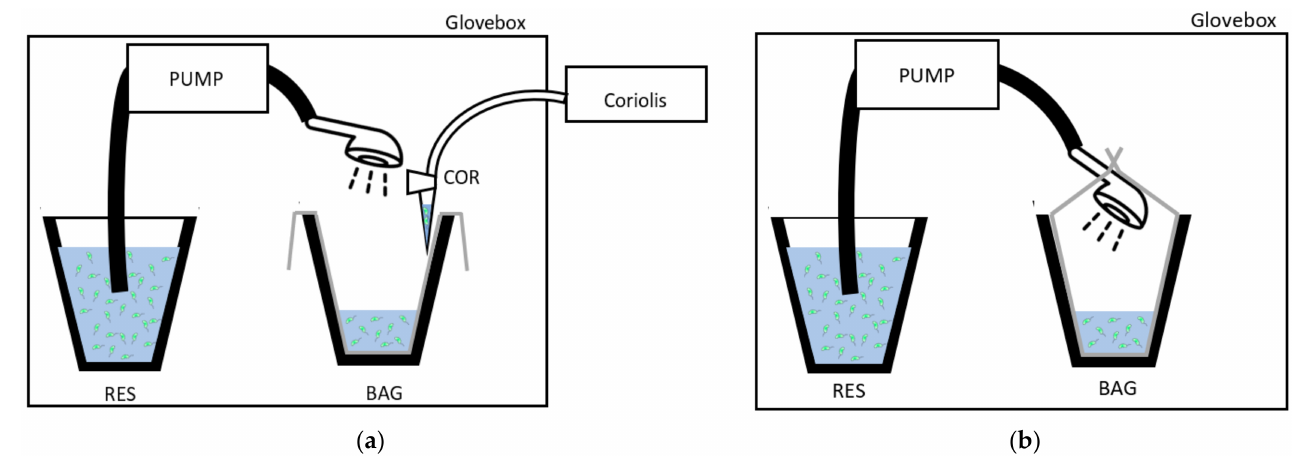
Figure 1. Experimental setup inside the glove box design ( a ) to collect the water contaminated with Legionella in controlled conditions in a bag (BAG); ( b ) to collect the bioaerosols during showering with a Coriolis ® Delta air sampler in a water sample (COR). RES: Legionella suspension